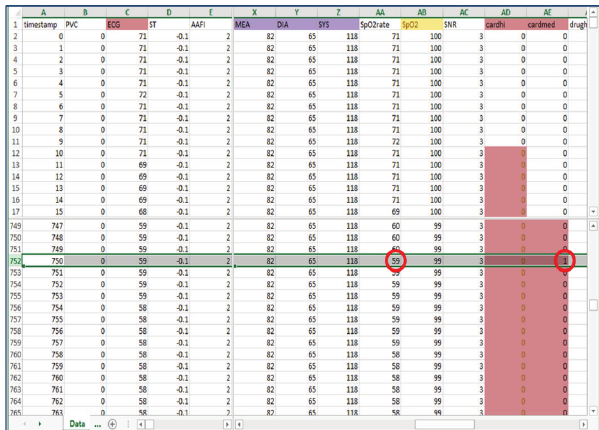
Figure 2: Screenshot of a portion of the “symptomatic bradycardia” XLS script. Note cell AA752 which shows the first time the heart rate drops below 60bpm and surpasses an alarm threshold. Cell AE752 programmatically changes to a value of 1 which instructs the GUI to annunciate the appropriate IEC alarm, in this case the medium priority cardiac alarm “cardmed.”